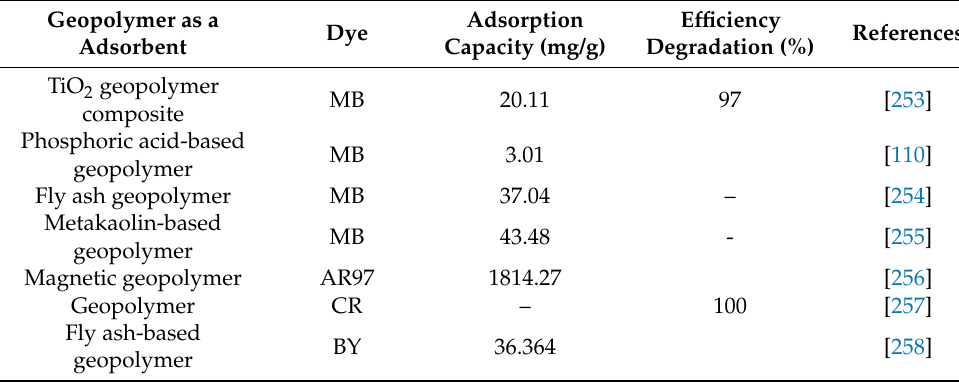
Table 2. Adsorption of dyes in different types of